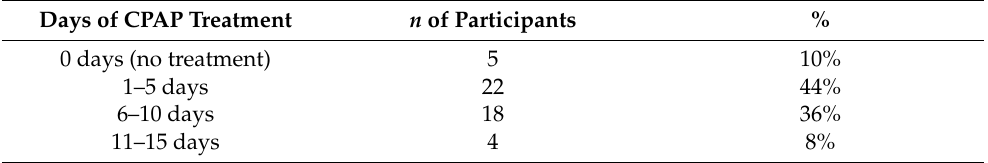
Table 1. Participants grouped for days of CPAP usage at the moment of the neuropsychological assessment. Days of CPAP treatment, number of participants, and percentages relative to the whole sample ( n = 50) are